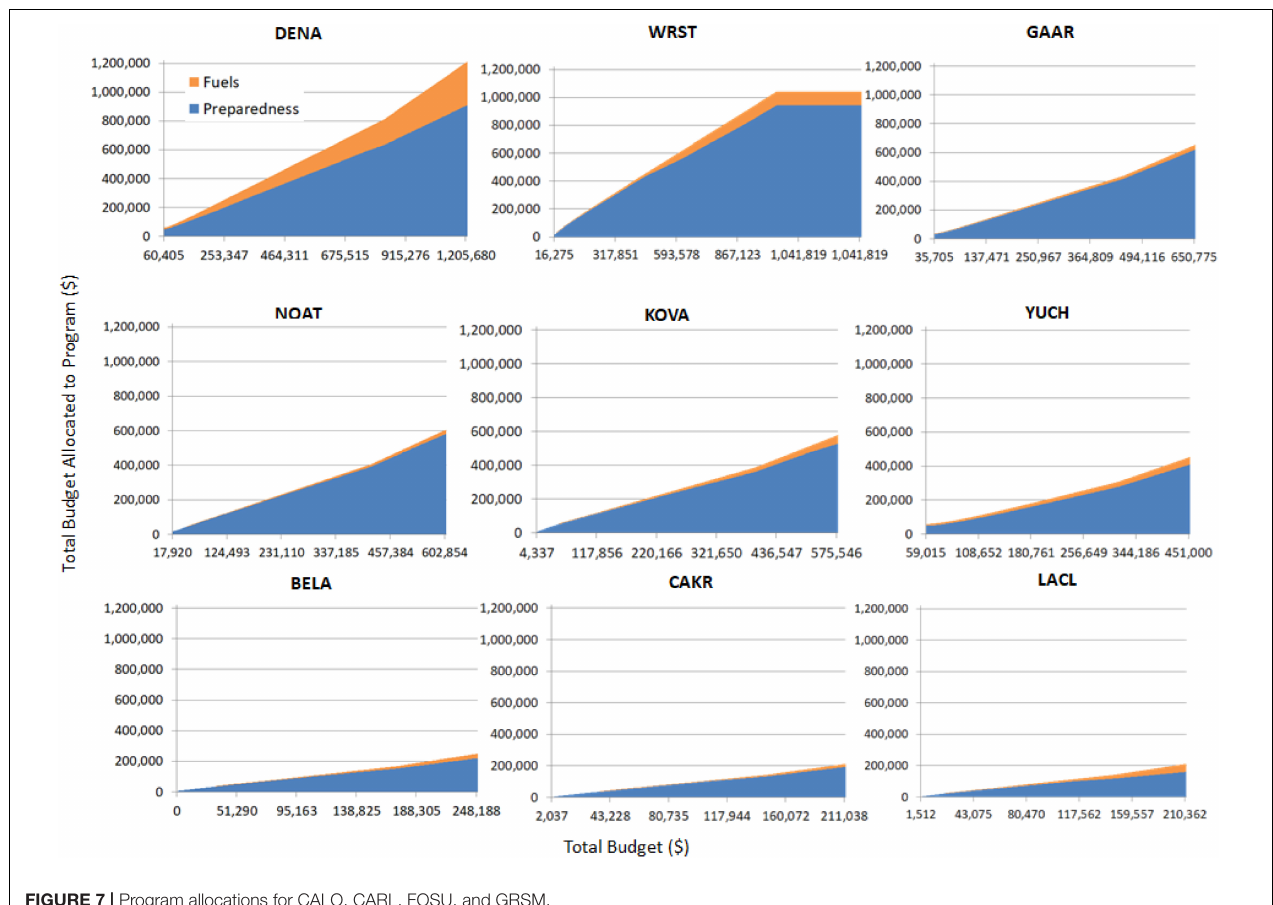
FIGURE 7 | Program allocations for CALO, CARL, FOSU, and GRSM.